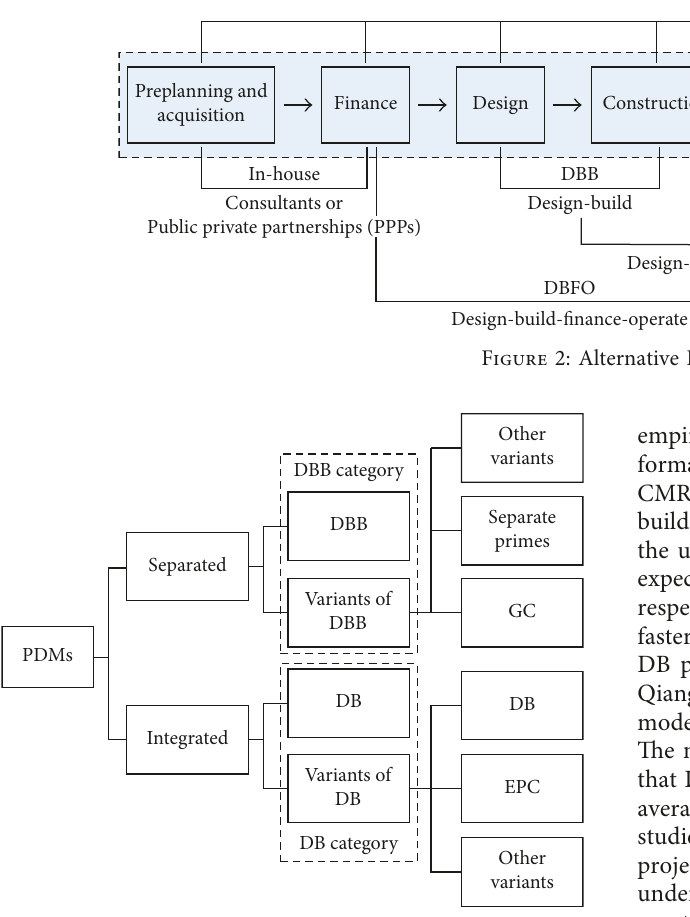
Figure 3: Classification of PDMs. Note: EPC may predate DB, but DB is always taken as one fundamental project, so here we take EPC as one variant of